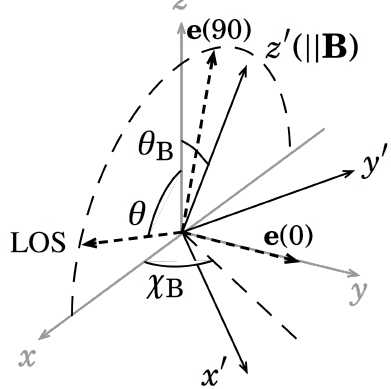
Figure 2. Geometrical relationship among the observation point, that is, the origin of the coordinates, the line-of-sight (LOS), and the magnetic field